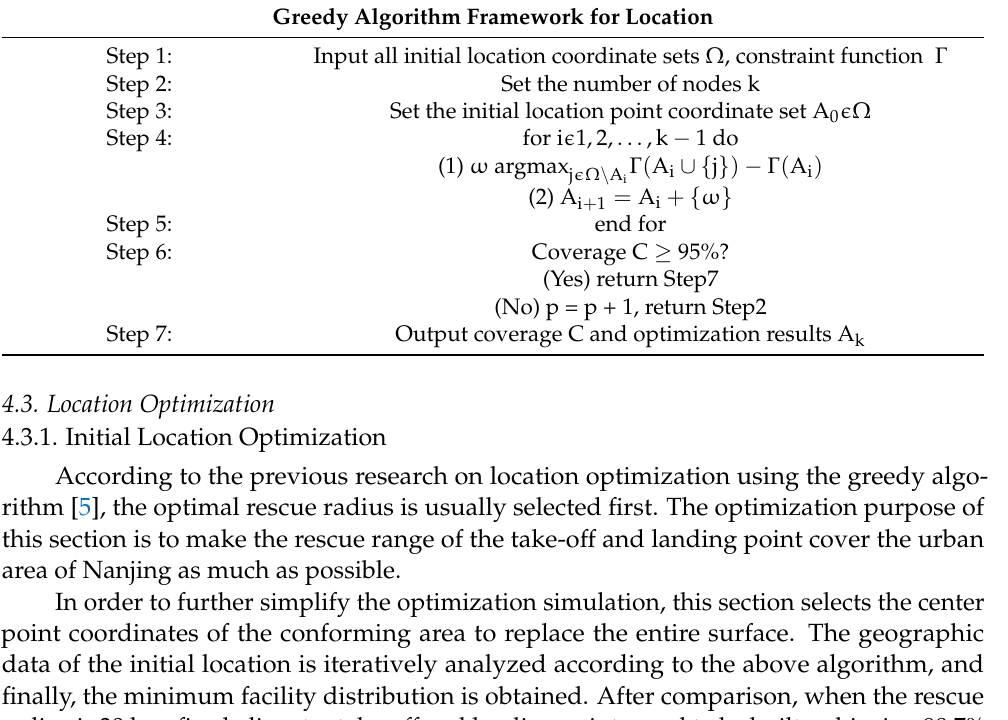
Table 5. Basic greedy algorithm framework. Greedy Algorithm Framework for Location